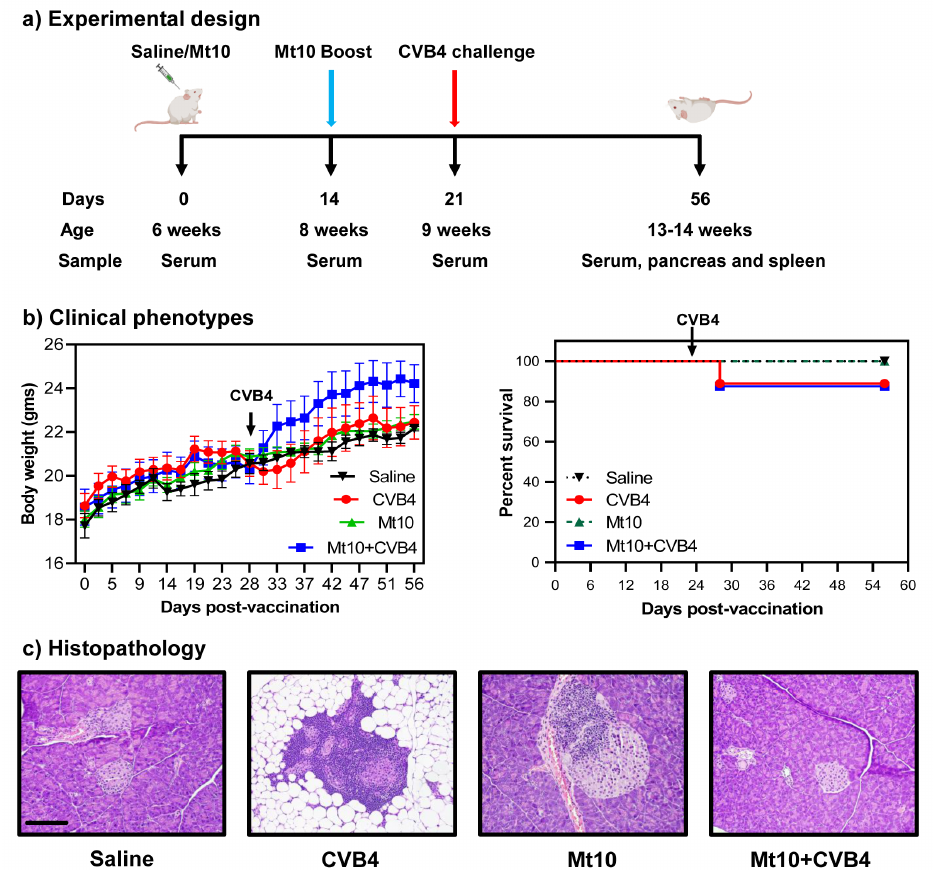
Figure 1. Mt10 vaccinated mice are protected from type 1 diabetes in challenge studies. ( a ) Experimental design. Groups of mice were given saline or were vaccinated with the Mt10 vaccine on days 0 and 14. After 7 days, CVB4 was administered to one group from each treatment. Experiments were terminated on day 56, and tissues were collected for histologic analysis. Serum was collected on days 0, 14, 21, and day 56 at termination. ( b ) Clinical phenotypes. Body weights (left panel) and survival rates (right panel) of different groups are shown. Generalized least square model was used to compare body weight changes in the saline, vaccine, and vaccine/challenged groups relative to the CVB4 group; log-rank test with Bonferroni correction was used to compare survival curves. ( c ) Histopathology. Pancreata preserved in 10% phosphate buffered formalin from the indicated groups were processed routinely and H. and E.-stained sections were evaluated for insulitis and other changes. Representative pancreatic sections are shown. Sections from the CVB4 group show destruc- tion of islets of Langerhans and fatty tissue replacement whereas the samples from the saline and Mt10/CVB4-challenged groups shown are essentially normal. The Mt10 sample shows peri-insulitis and insulitis. Magnification, 20 × ; scale bar = 100 µ m, applies to all panels. Data obtained from each group involve 5–10